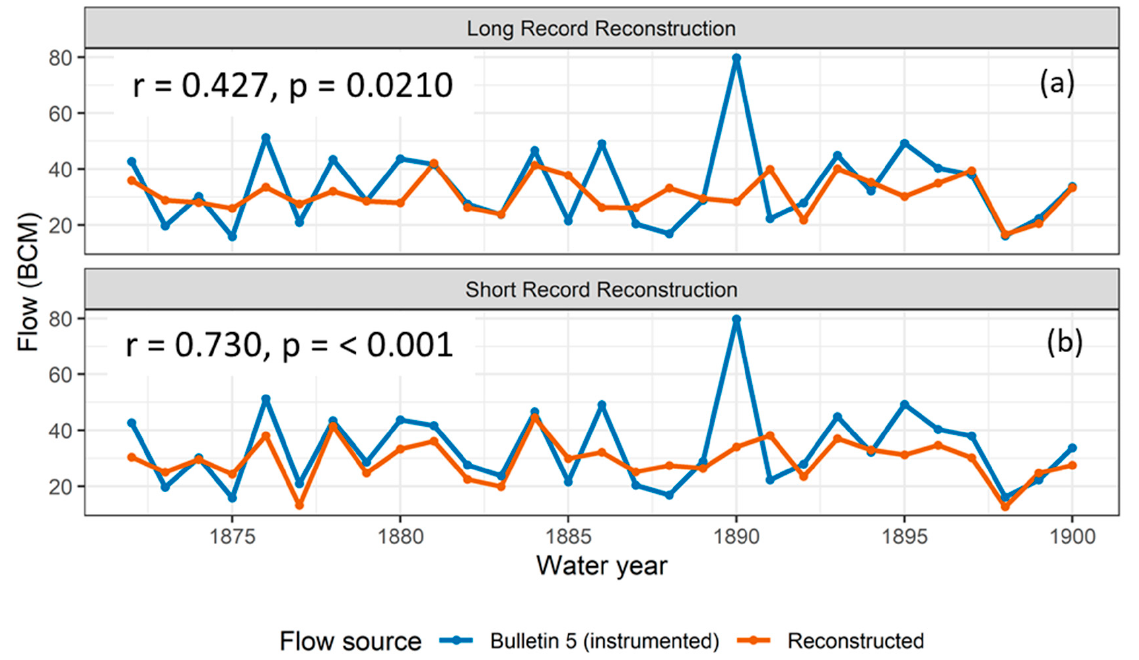
Figure 3. Time series plots (WYs 1872–1900) comparing reconstruction of Central Valley runoff (Model 1) with instrumented flows for ( a ) long record reconstruction and ( b ) short record reconstruction. Spearman correlations and significance annotated. Significance not adjusted for autocorrelation because none of the series are positively autocorrelated. This period, as documented in Bulletin 5 [65], precedes years used for calibrating and validating reconstruction